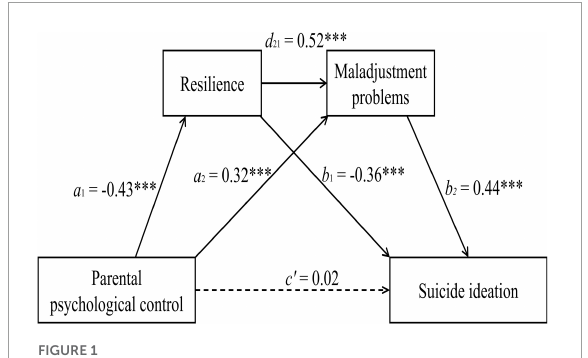
TABLE 4 The direct and indirect effects in chained mediation model after controlling the effects of gender and grade ( n =